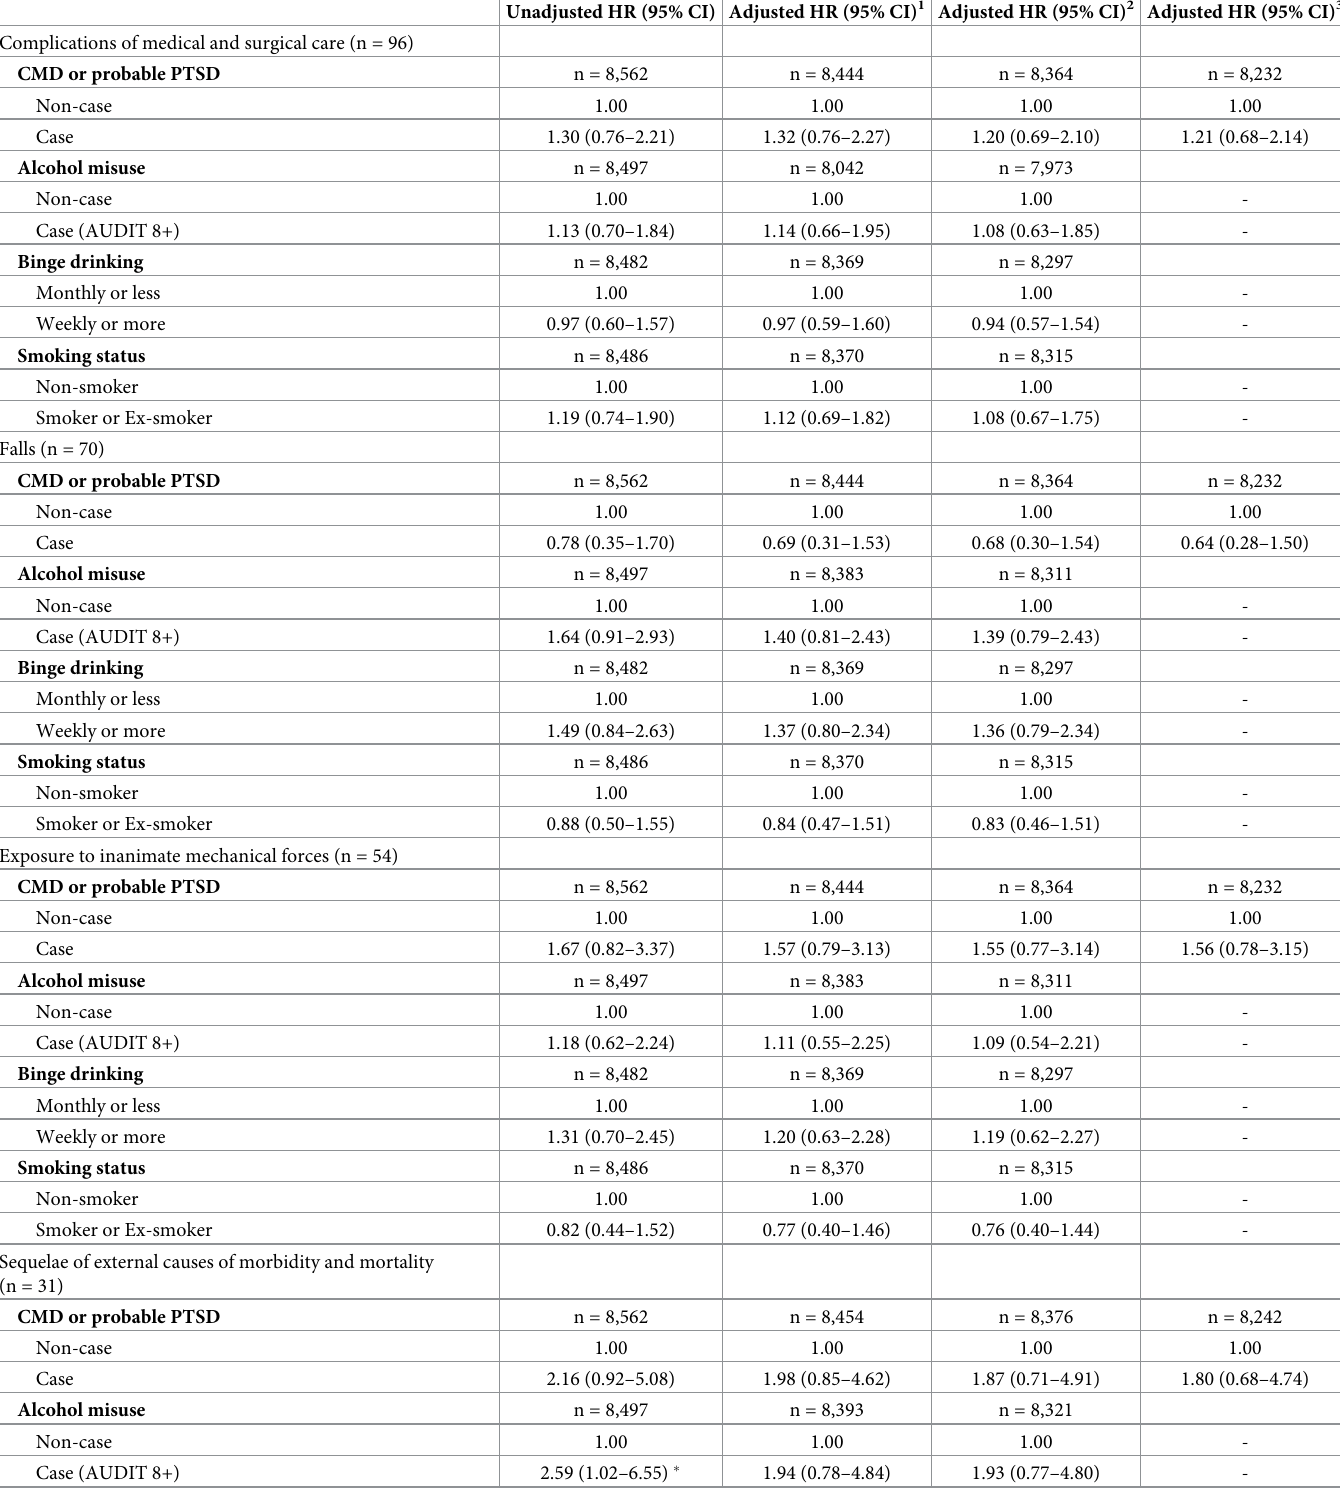
Table 4. Risk factors at phase 2 associated with time to admission to hospital for the five most common accidents and